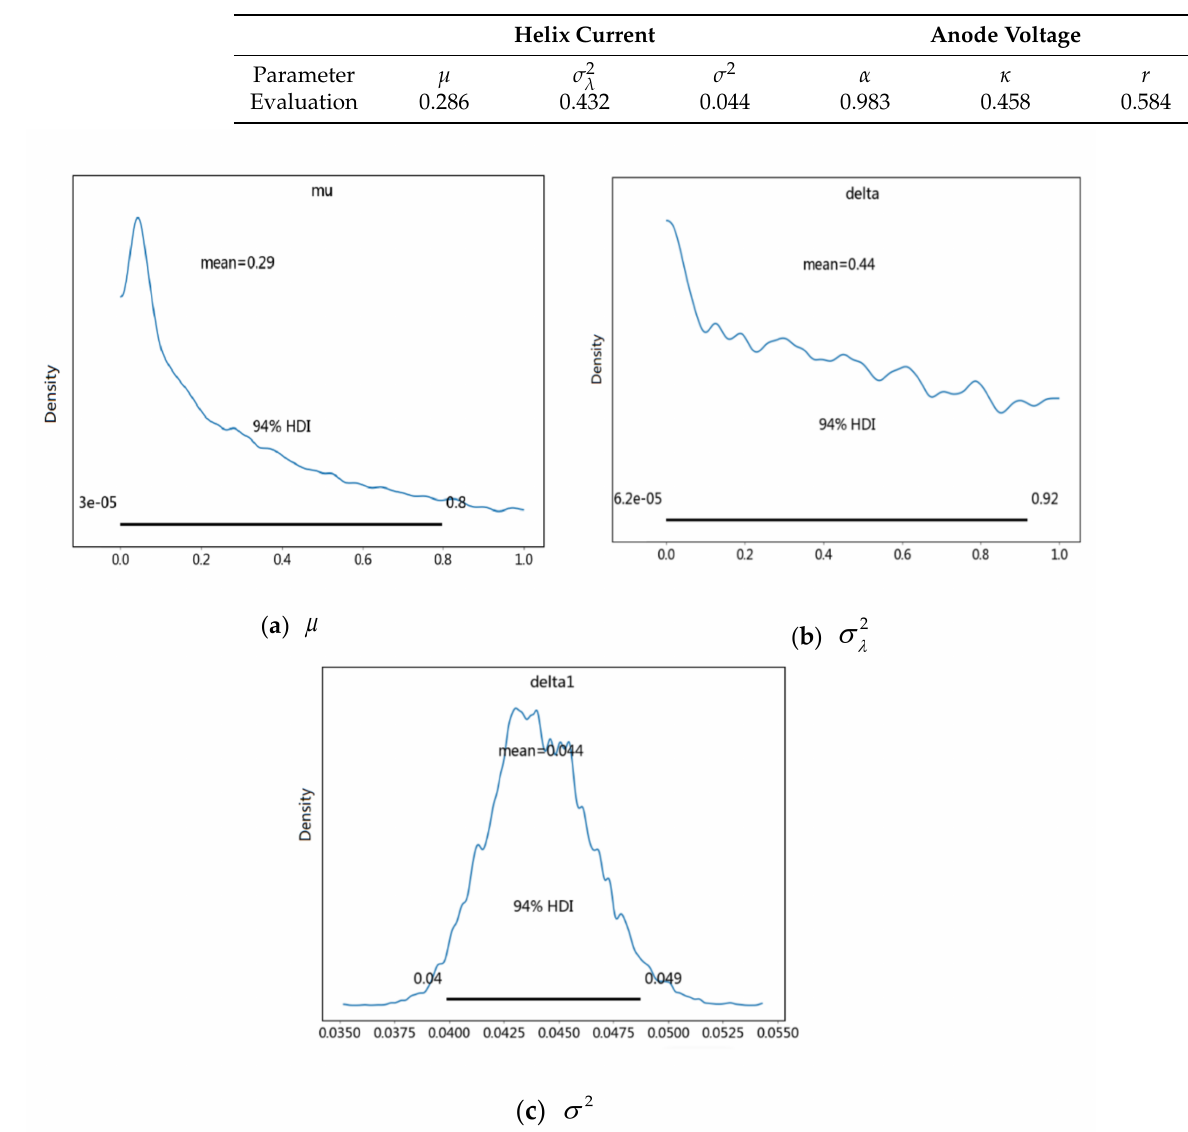
Table 2. The estimation results of unknown parameters.